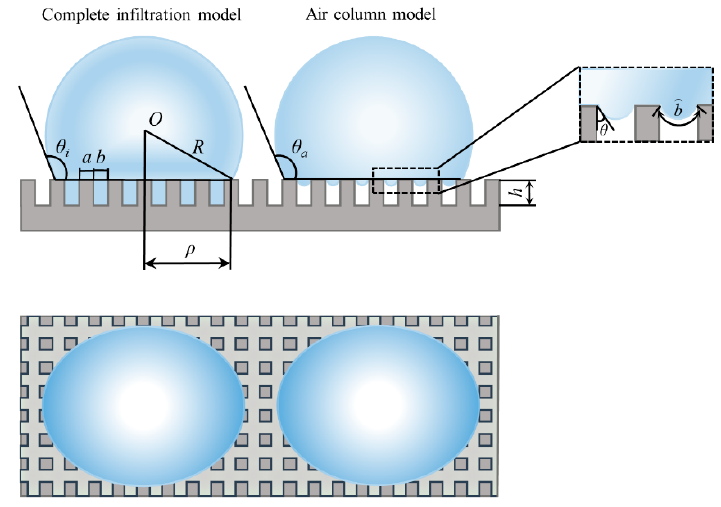
Figure 1. Diagram of the square column model.